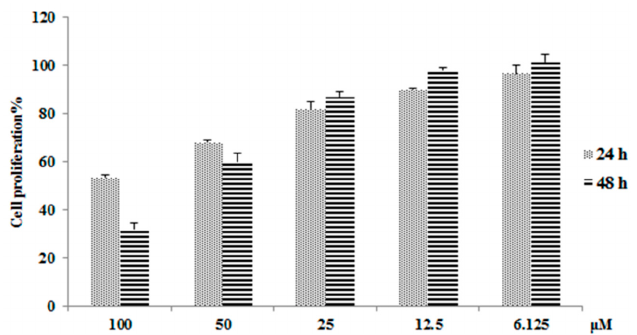
Figure 1. Cell proliferation results by Cell Counting Kit-8 (CCK-8) assay after emodin administrated for 24 h and 48 h (means ± SD, n = 3).